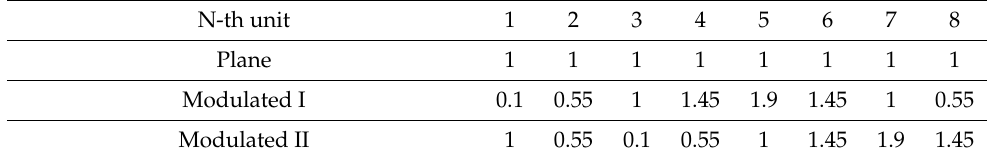
The range of the azimuth and elevation directions is [ − 20 ◦ , 20 ◦ ]